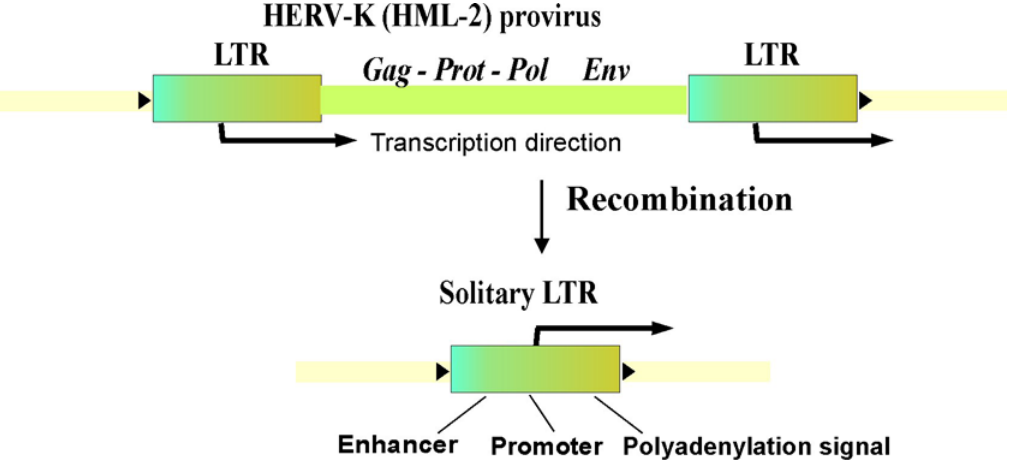
FIGURE 2. Major part of HERV-K (HML-2) elements exist in the form of solitary LTRs, arisen due to homologous recombination events between the identical LTRs flanking proviral genes Gag , Prot , Pol , and Env . Each LTR harbors polyadenylation signal, enhancer, and promoter elements, and can initiate transcription of the downstream genomic